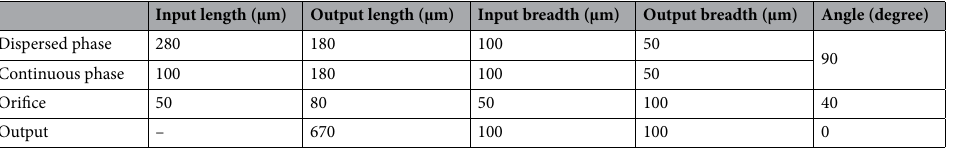
Table 1. Point by point sizes of